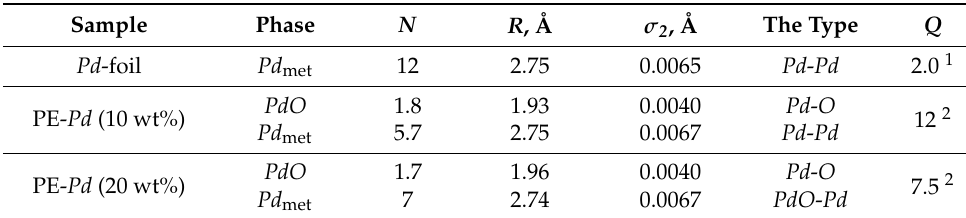
Table 1. Structural data for the local atomic environment of Pd atoms obtained by two-sphere EXAFS fitting ( R are the interatomic distances, N is the coordination number, σ 2 is the Debye-Waller factor, and Q is the fit quality